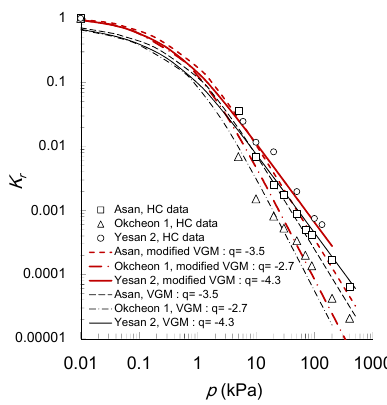
Figure 9. Comparison of the measured hydraulic conductivities with the modified model in Group